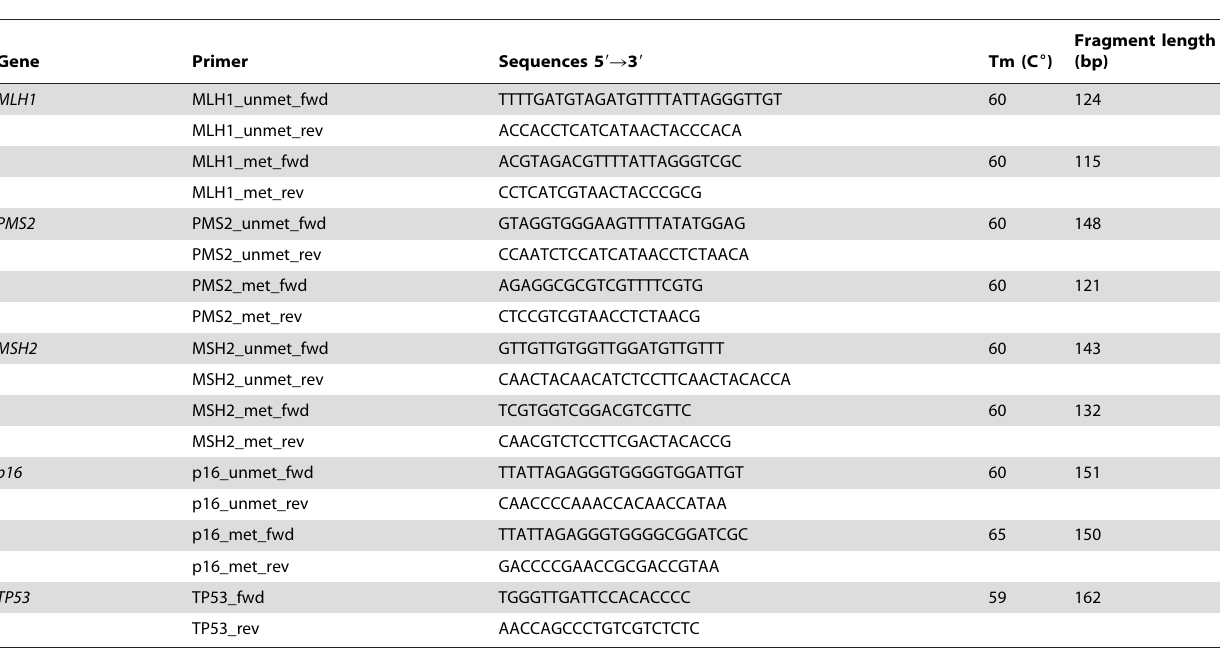
Table 2. Primer sequences and annealing temperatures used in